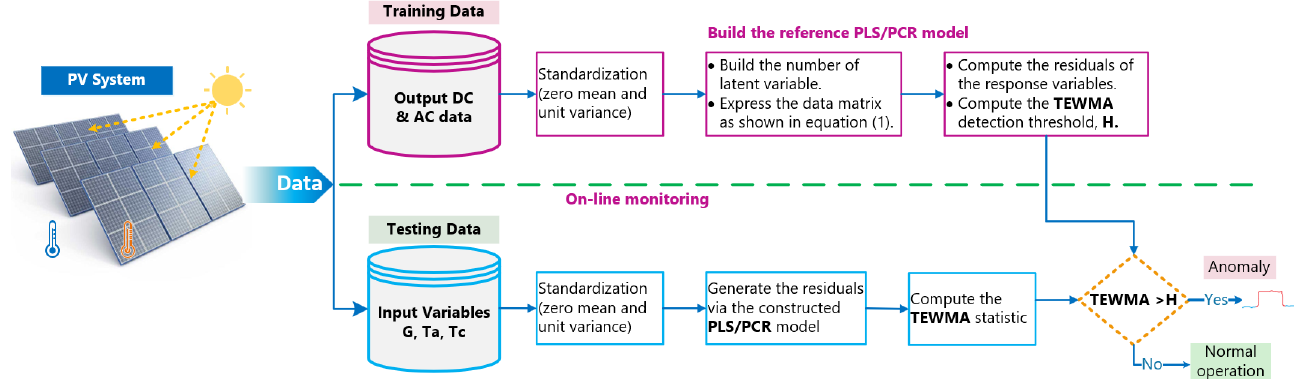
Figure 12. General fault detection procedure in PV system using LVR-based KDE triple exponentially smoothing driven monitoring schemes.